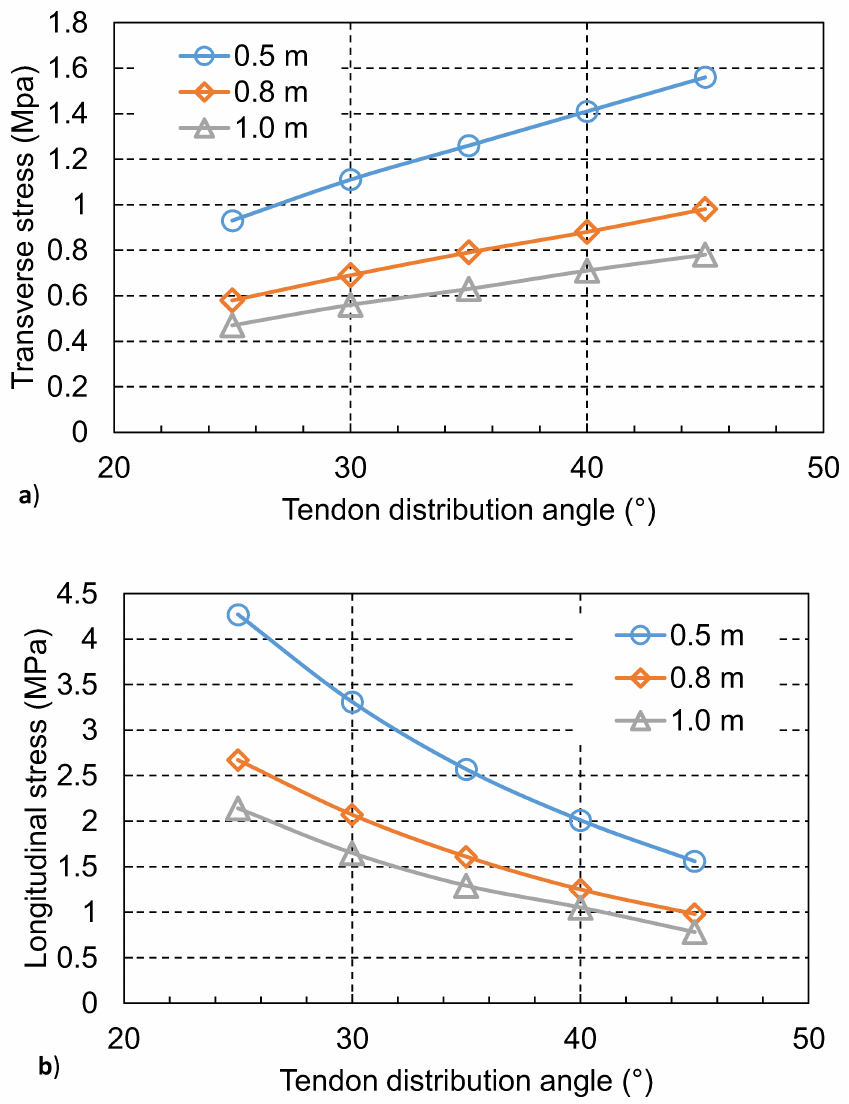
Figure 5. The effect of tendon distribution and spacing on the stress level in concrete slab: ( a ) longitudinal stress; and ( b ) transverse